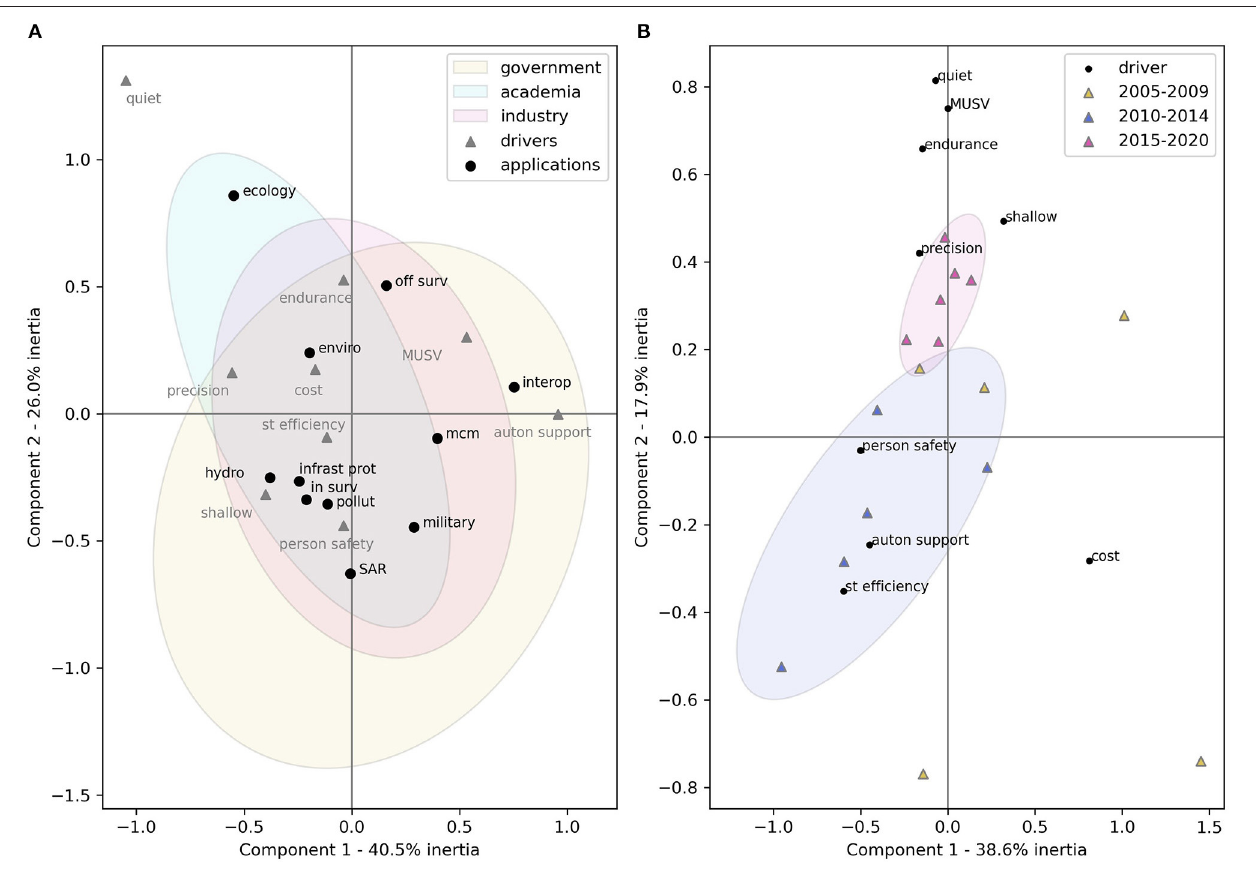
FIGURE 3 | Correlation analysis of USV applications and their drivers (A) , and drivers and publication year (B) . The ellipse for years 2005–2009 was excluded as there was no clear